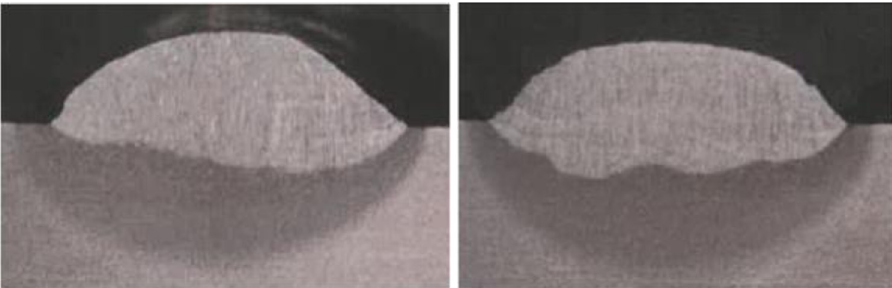
Figure 4: The welds ’ microstructures were produced with 70 o torch angle shown in the picture on the left and 110 o torch angle shown in the picture on the right.